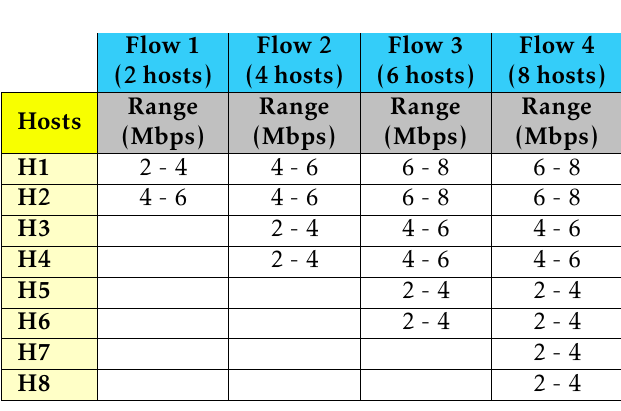
Table 2. Evaluation Flows